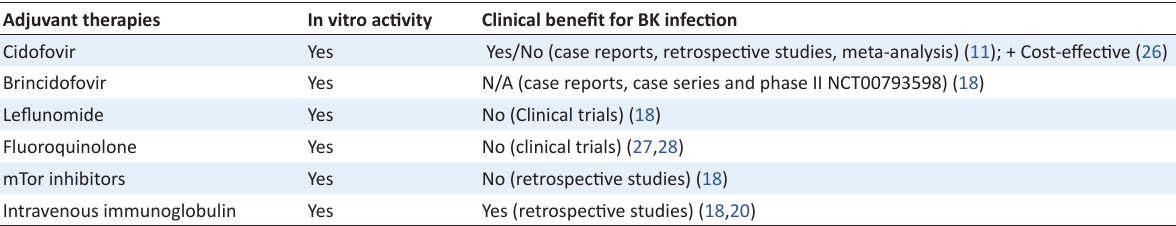
Table 1. Proposed Adjuvant therapies for BKVAN Adjuvant therapies In vitro activity Clinical benefit for BK